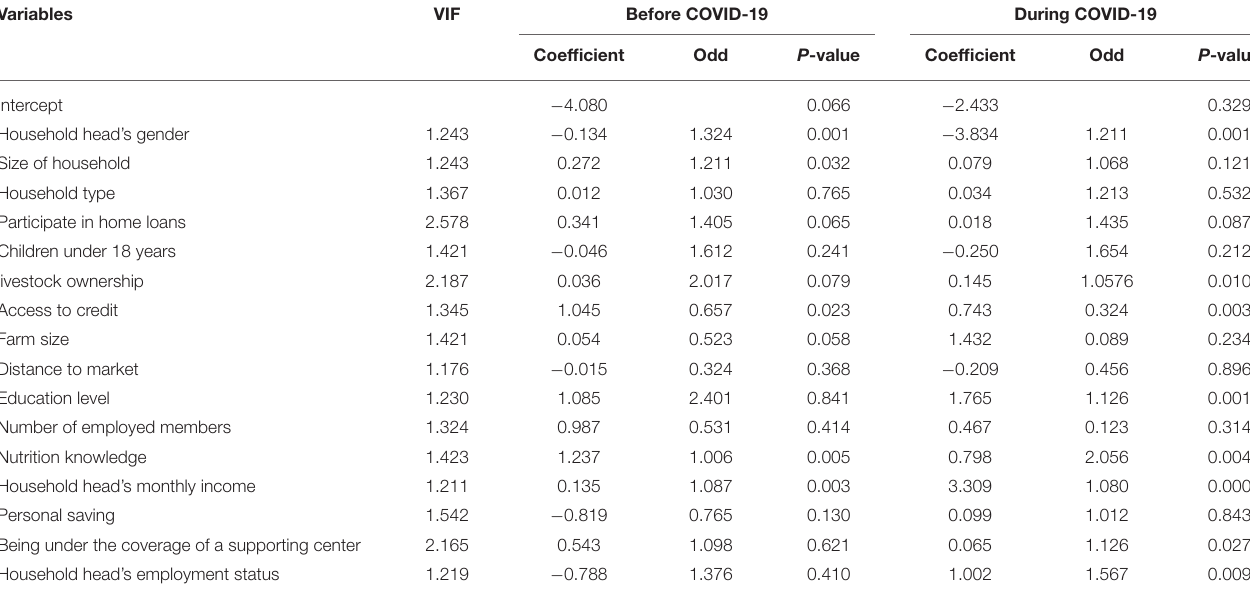
TABLE 7 | Factors associated with dietary diversity before and during COVID-19 using multinomial